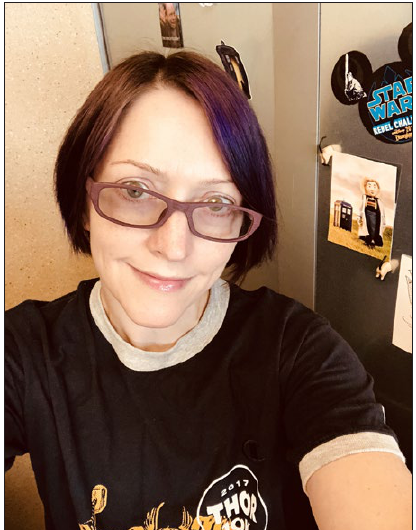
Figure 6: Former IoA student Lisa Grimm who now works in the tech industry (Photo Lisa